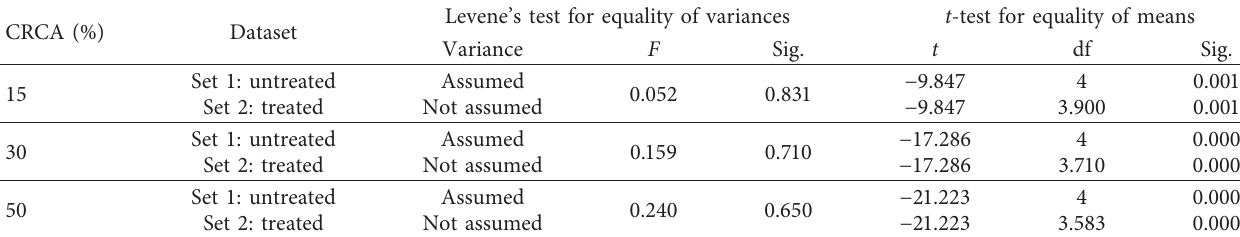
Table 6: Results of t -test to investigate the effect of CRCA percentage on the Marshall quotient.